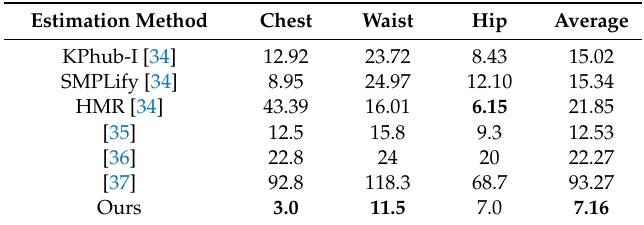
Table 7. Comparative results of body part perimeters according to the absolute error (expressed in millimeters). Lower values are better. The best results are in